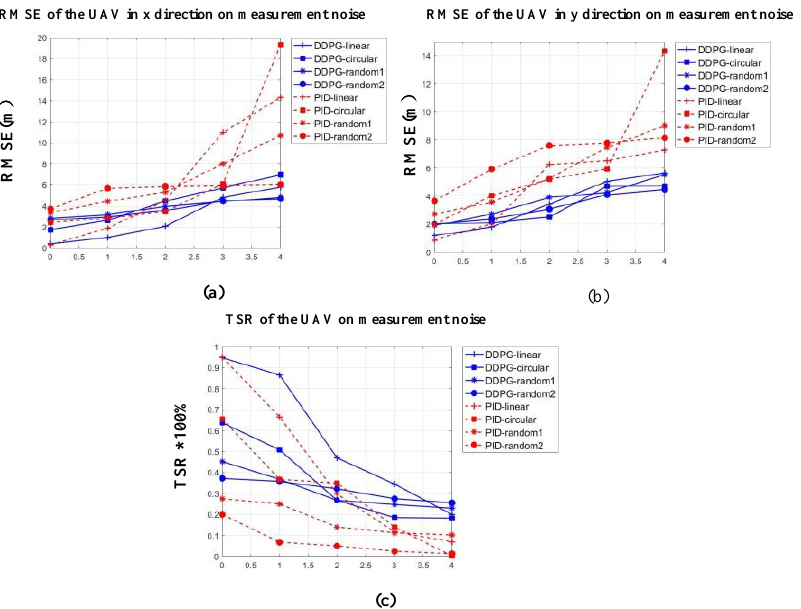
Figure 8. Tracking results on measurements error: ( a ) root-mean-square error (RMSE) of UAV in the x-direction, ( b ) RMSE of UAV in the y-direction, and ( c ) tracking success rate (TSR) of UAV.